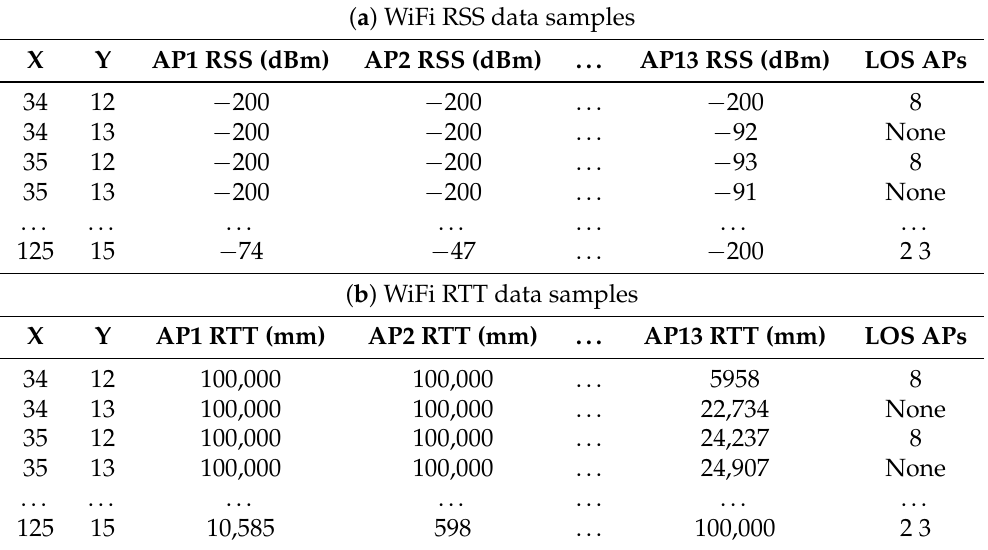
Table 3. A Snapshot of the proposed WiFi